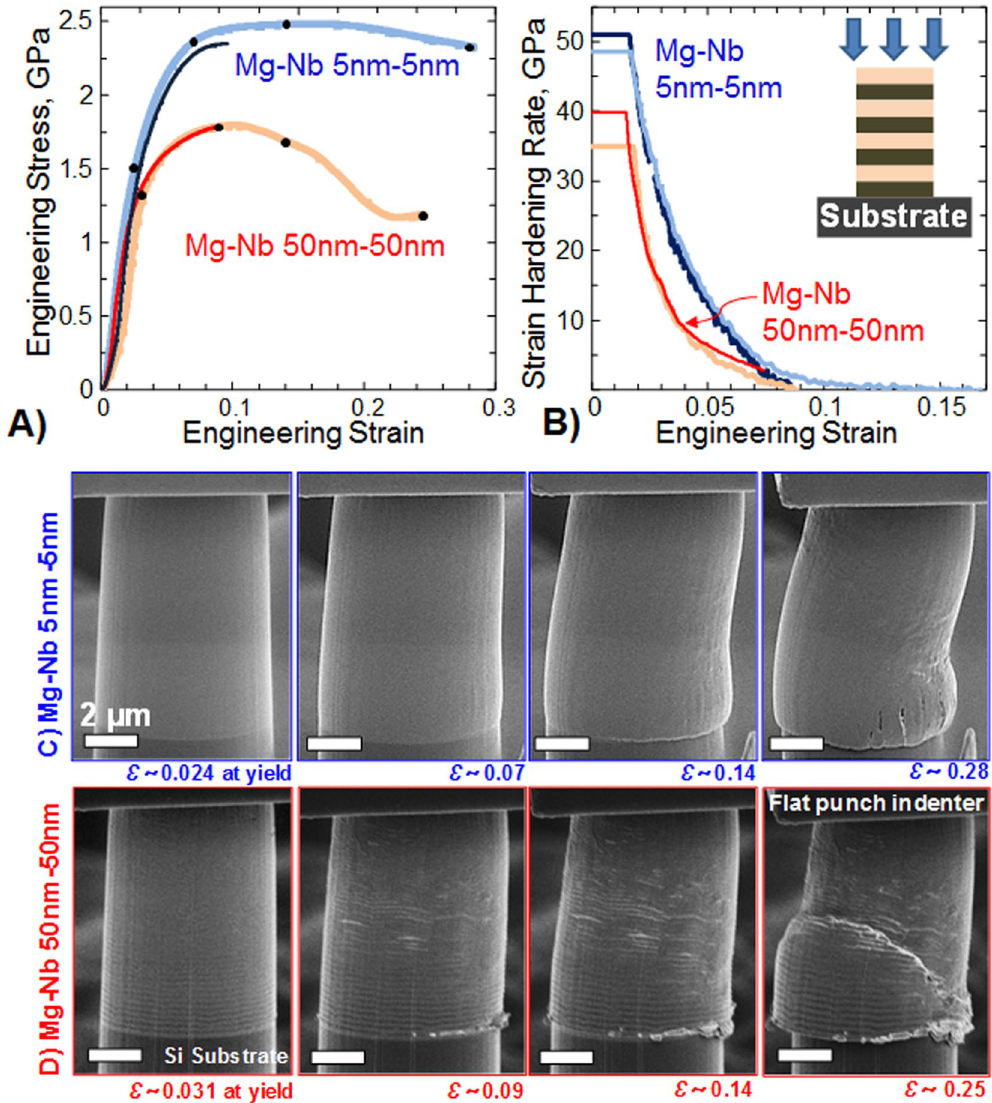
Figure 3. ( a ) Engineering stress-strain curves and ( b ) strain hardening rates obtained from micropillar compression tests of 5 nm/5 nm bcc/bcc and 50 nm/50 nm hcp/bcc Mg/Nb nanocomposites. Two representative tests for each layer thickness, one stopped at lower strains ( ɛ ~ 0.1) and another at higher strain levels ( ɛ ~ 0.25– 0.3), are shown in order to demonstrate the repeatability of the results. ( c and d ) The micropillar compression process was recorded as a video file from which individual picture frames were extracted corresponding to strain levels of ( c ) ε ≈ 0.024, 0.07, 0.14 and 0.28 for the 5 nm/5 nm Mg/Nb nanocomposite and ( d ) ε ≈ 0.031, 0.09, 0.14 and 0.25 for the 50 nm/50 nm Mg/Nb nanocomposite (as indicated by the black dots on the stress- strain graph in ( a